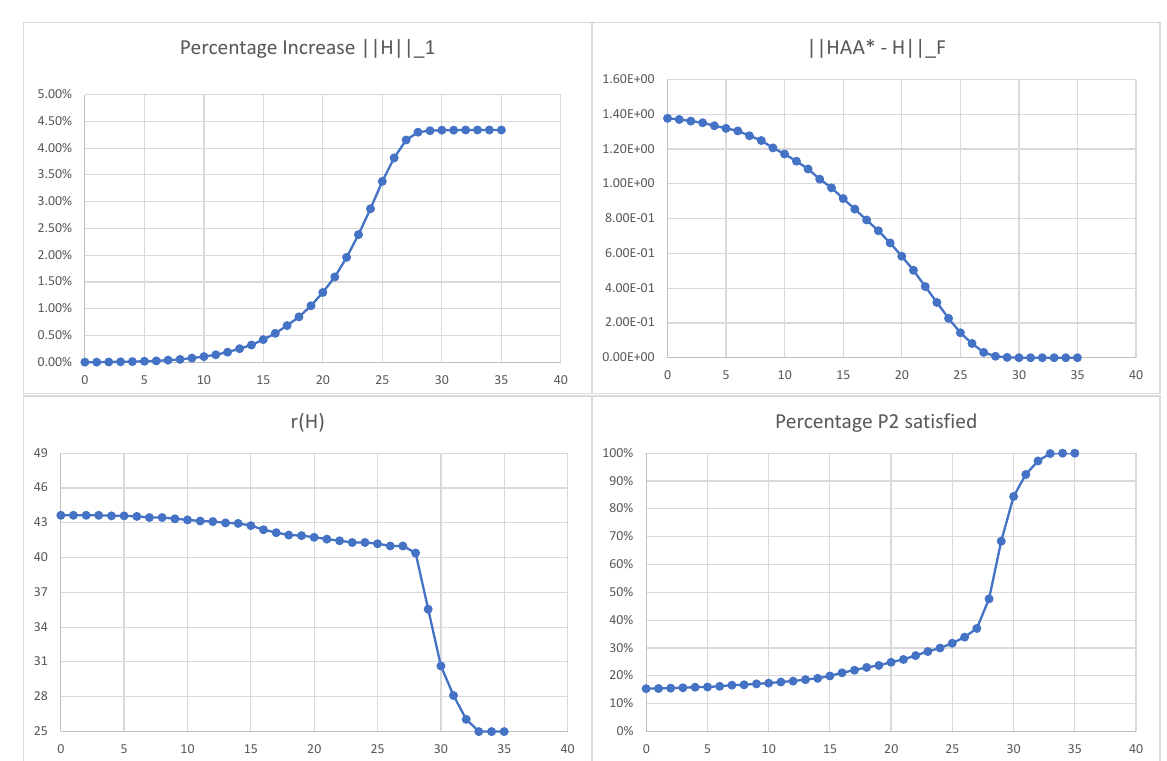
Figure 4 Augmented Lagrangian method